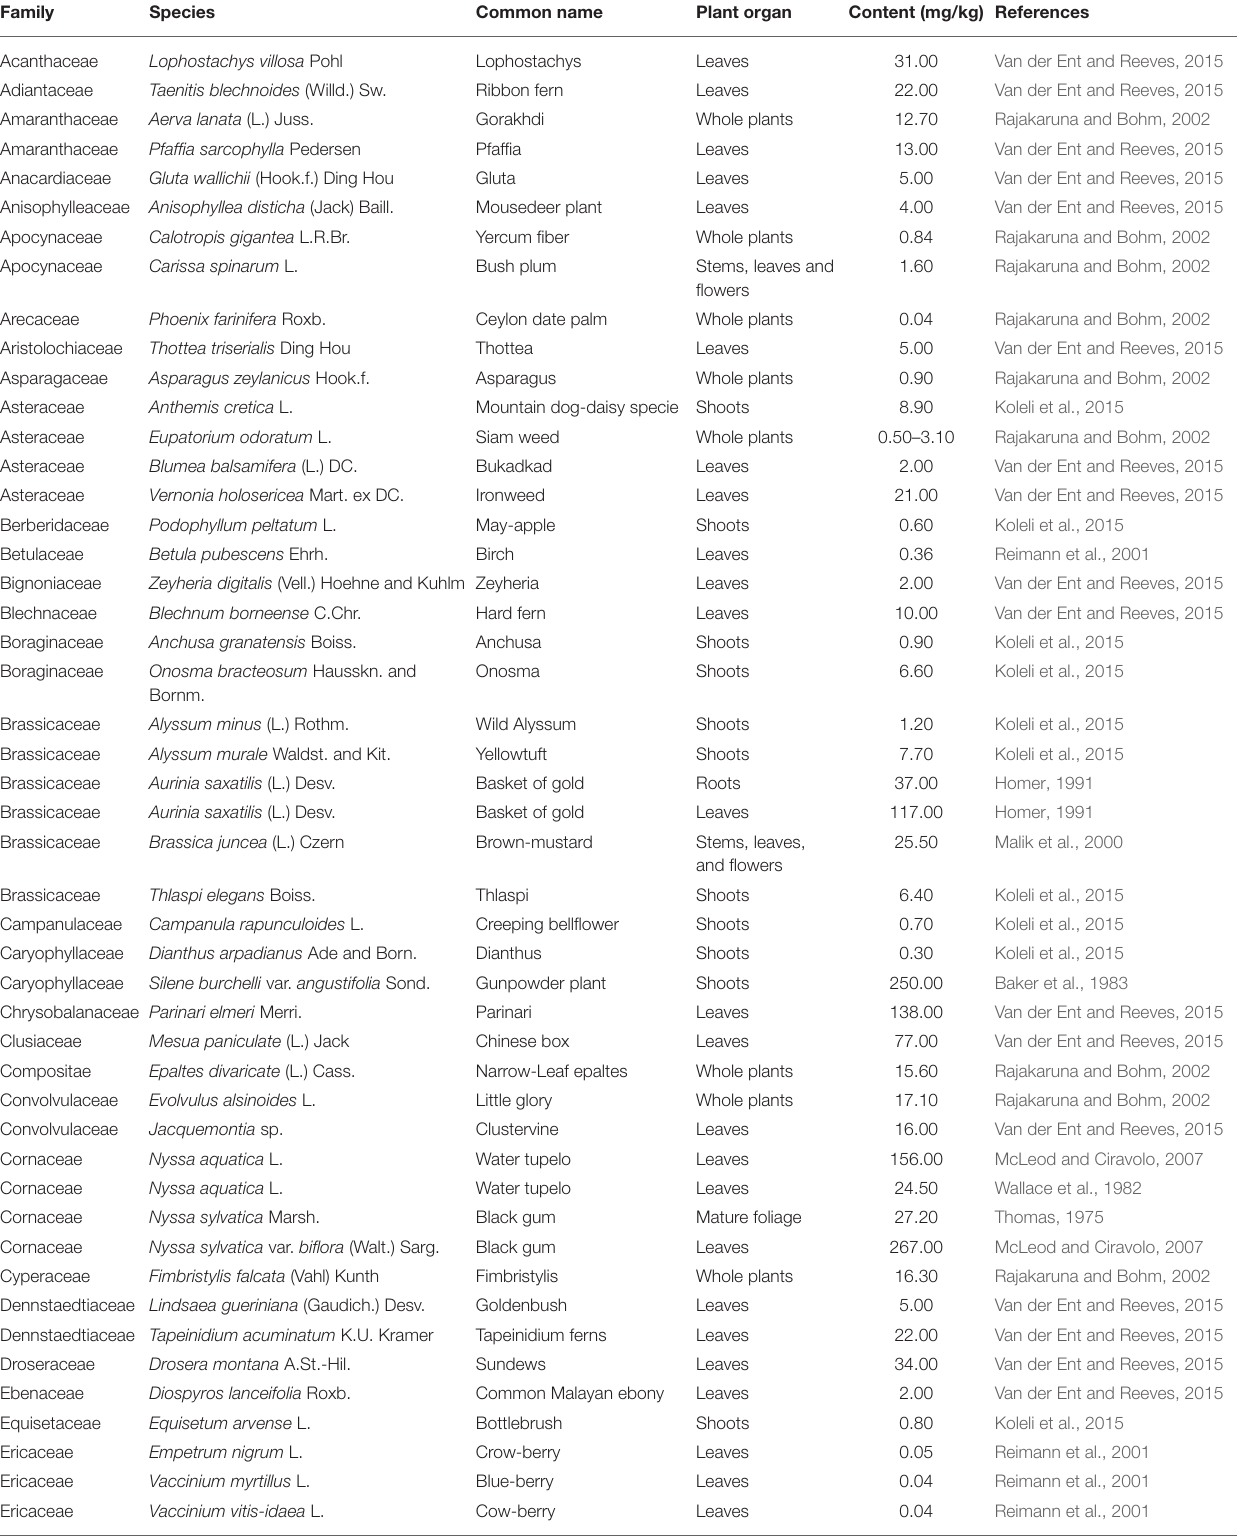
TABLE 3 | The concentration of cobalt in higher plants with the exclusion of cobalt